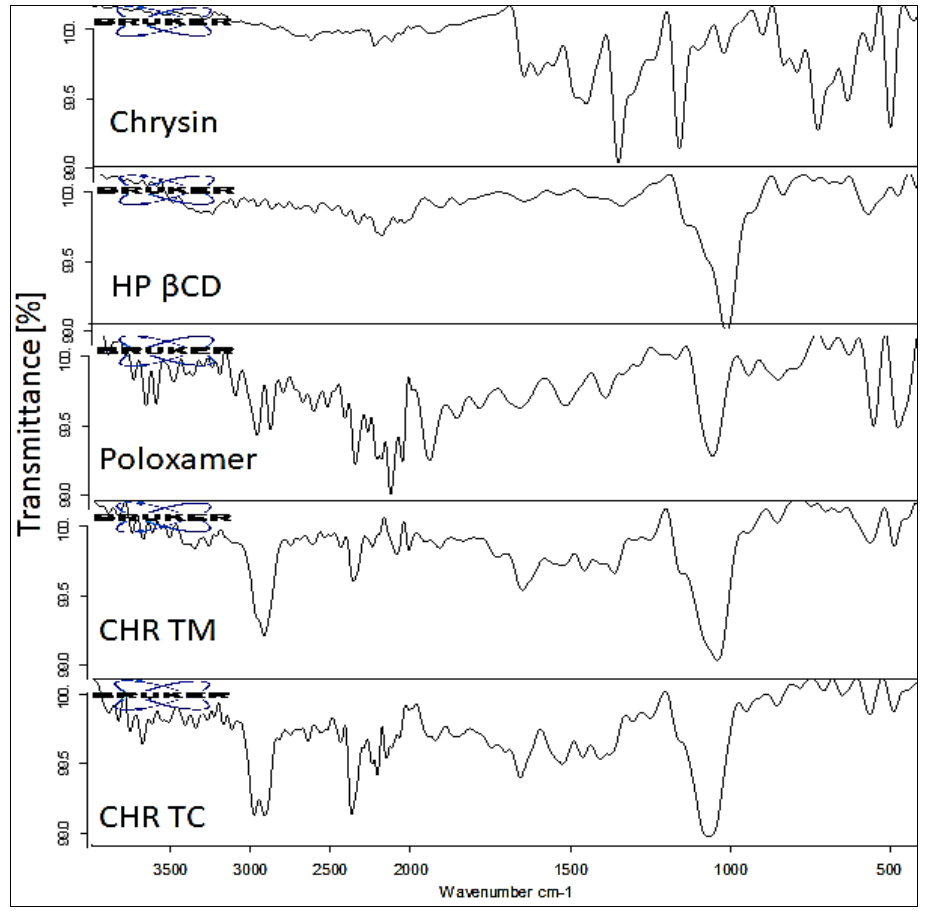
Figure 4. IR spectra of pure CHR, HP β CD, PLX, Chrysin ternary mixture (CHR-TM), and Chrysin ternary complex (CHR-TC).